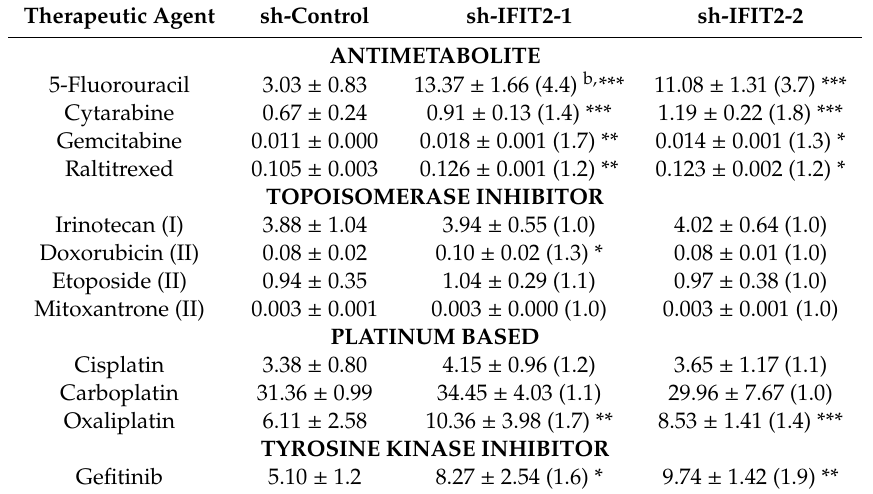
Table 1. In vitro cell viability assay of di ff erent therapeutic agents in IFIT2-knockdown cells a . Therapeutic Agent